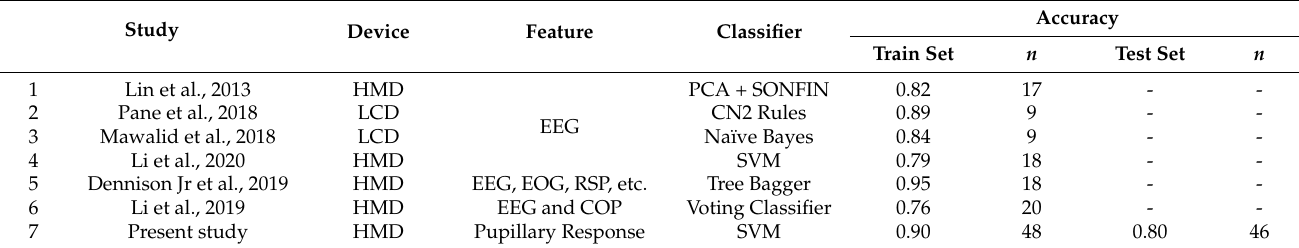
Table 2. Performance comparison of the proposed method and previous methods of motion-sickness.